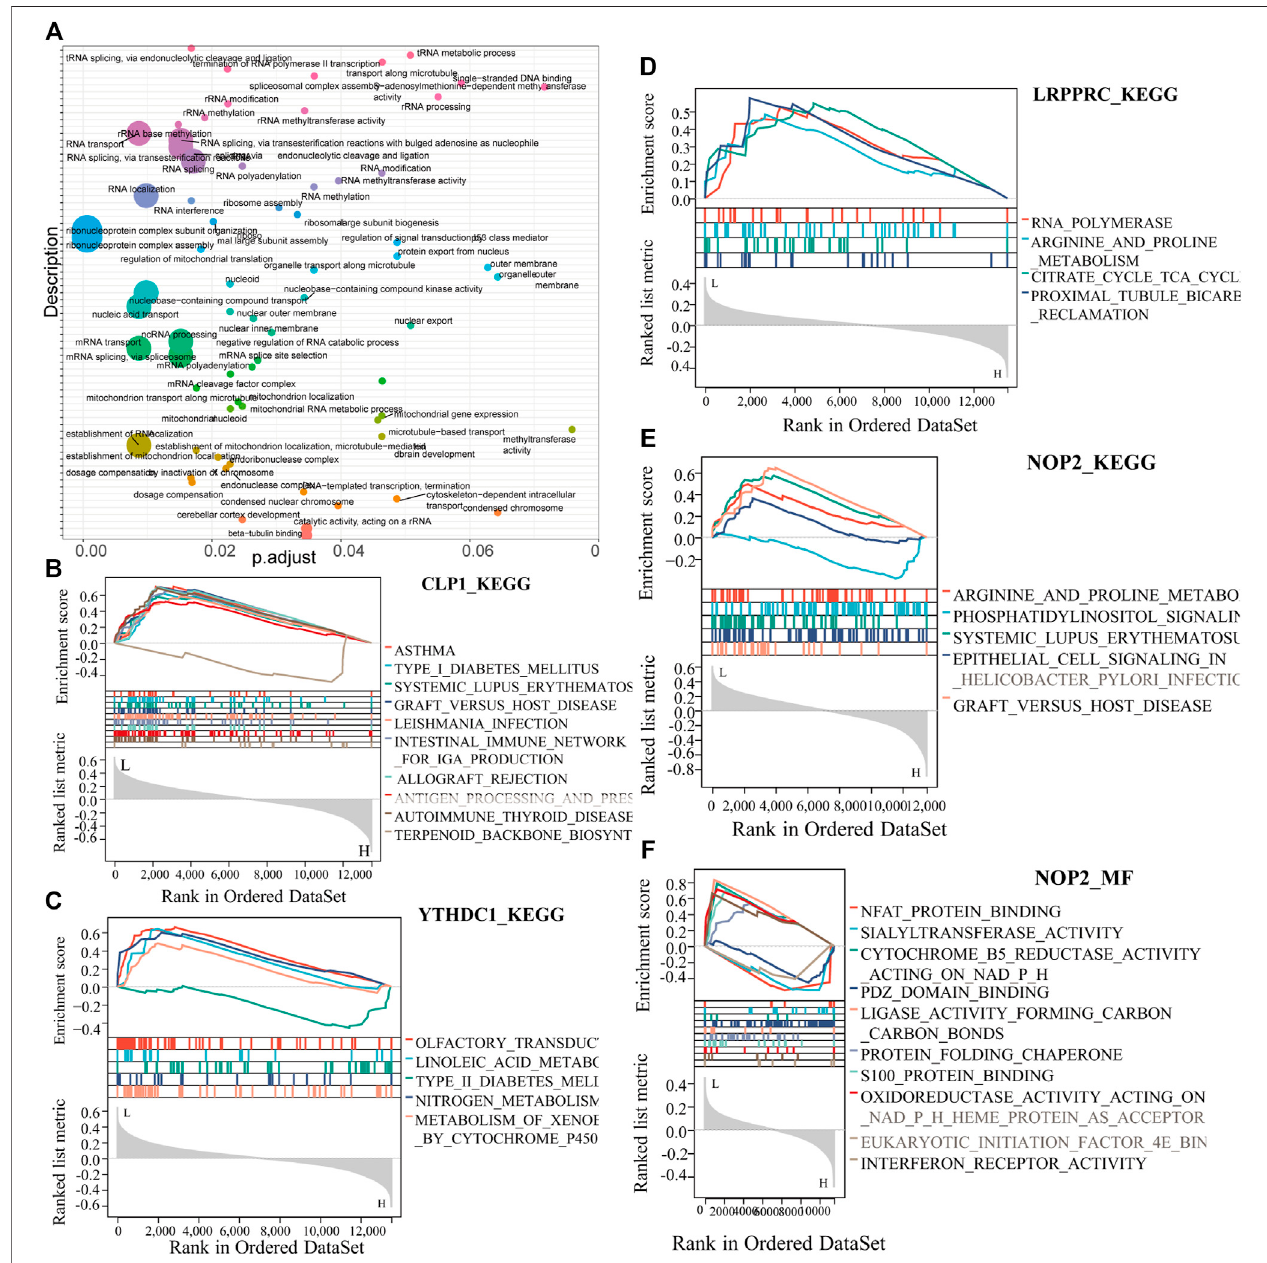
FIGURE 10 | Key gene GESA-KEGG analysis. (A) : Summary of key gene GSEA-KEGG functions, the horizontal axis represents the P-adjust value, (B – E) : CLP1, YTHDC1, LRPPRC, NOP2 GSEA-KEGG function enrichment results. (F) : NOP2-MF function analysis.